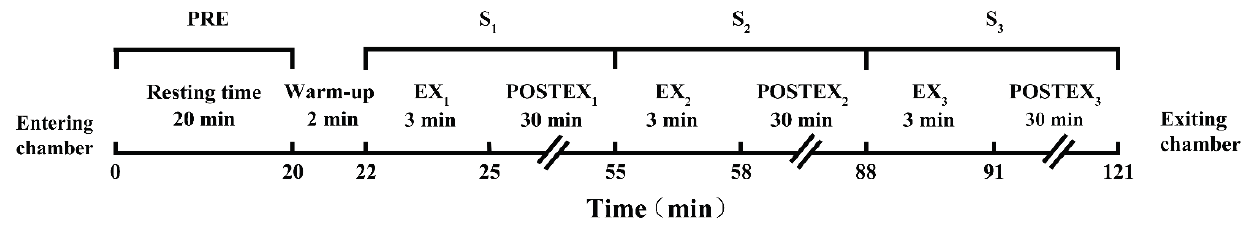
Figure 1. Exercise test protocol. PRE, pre-exercise. S 1 , S 2 and S 3 , segment 1, segment 2 and segment 3. EX 1 , EX 2 and EX 3 , the first, second and third exercise. POSTEX 1 , POSTEX 2 and POSTEX 3 , the first, second and third